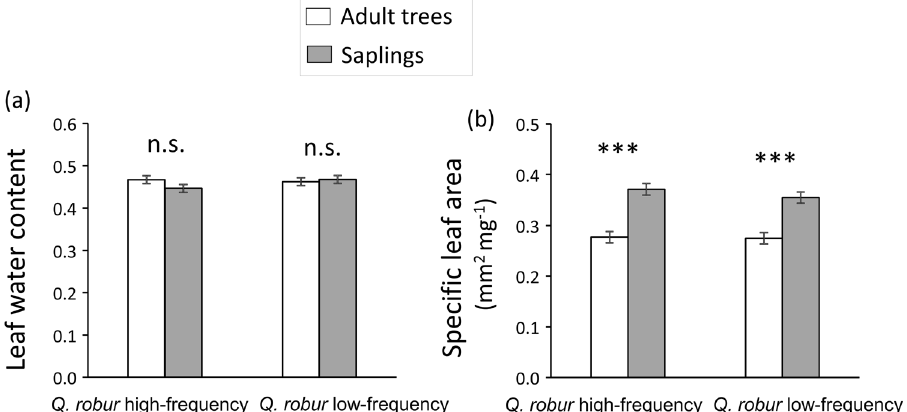
Figure 2. Effect of plant neighbourhood composition and ontogeny on plant physical traits in Quercus robur . ( a ) Proportion of leaf water content and ( b ) specific leaf area (mm 2 mg − 1 ) in adult trees (white bars) and saplings (grey bars) growing in Q. robur high-frequency and low-frequency stands. Bars are least square means ± standard error (N = 60). Asterisks indicate significant ontogenetic differences within each Q. robur stand type at P < 0.001 ( *** ). n.s. = non-significant.